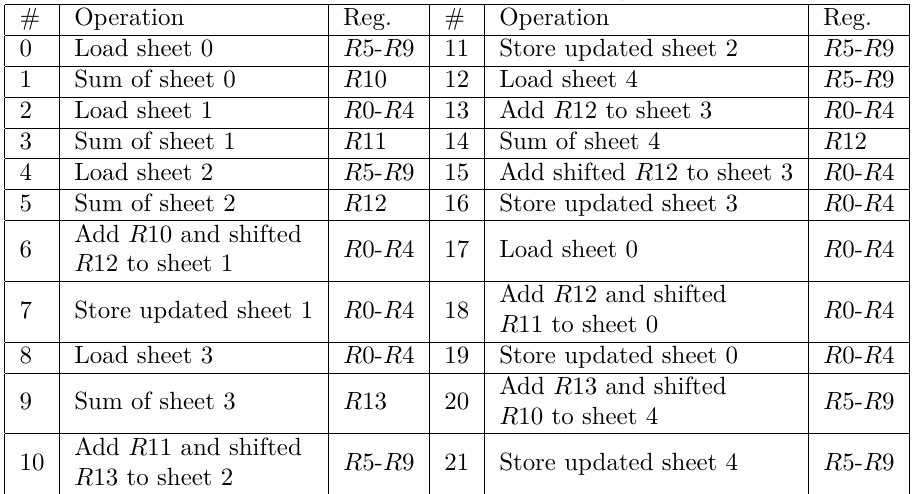
Table 3: Step-by-step execution of θ on domain A using four temporary